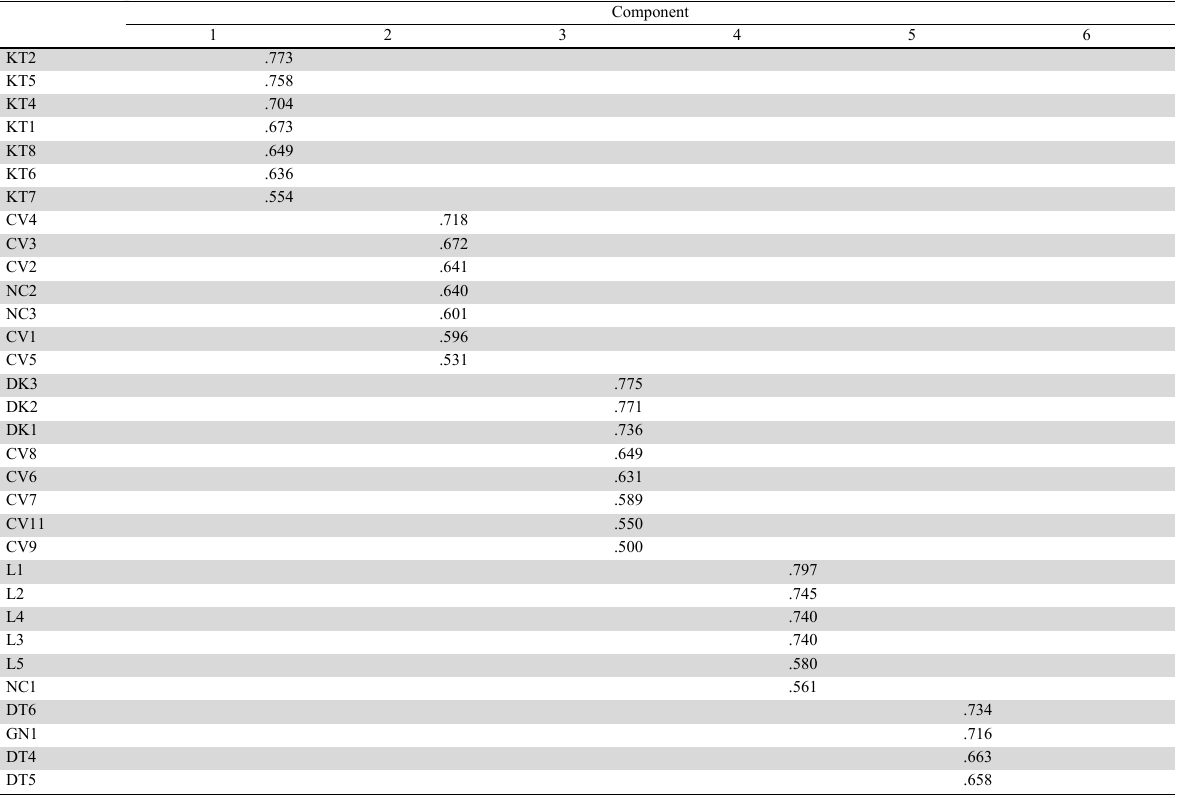
Rotated Component Matrix a